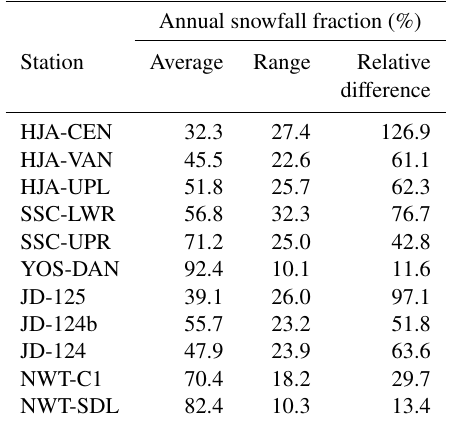
Table 4. Statistics for average annual snowfall fraction computed using the different precipitation phase methods across all simulation years at the 11 study stations. The range was calculated by subtract- ing the lowest average annual snowfall fraction from the highest average annual snowfall fraction at each station. The relative differ- ence was then computed as the range divided by the minimum and multiplied by 100%. T a0 and T ar0 typically produced the lowest av- erage annual snowfall fractions, while T a3 and T d1 led to the highest average annual snowfall fractions.